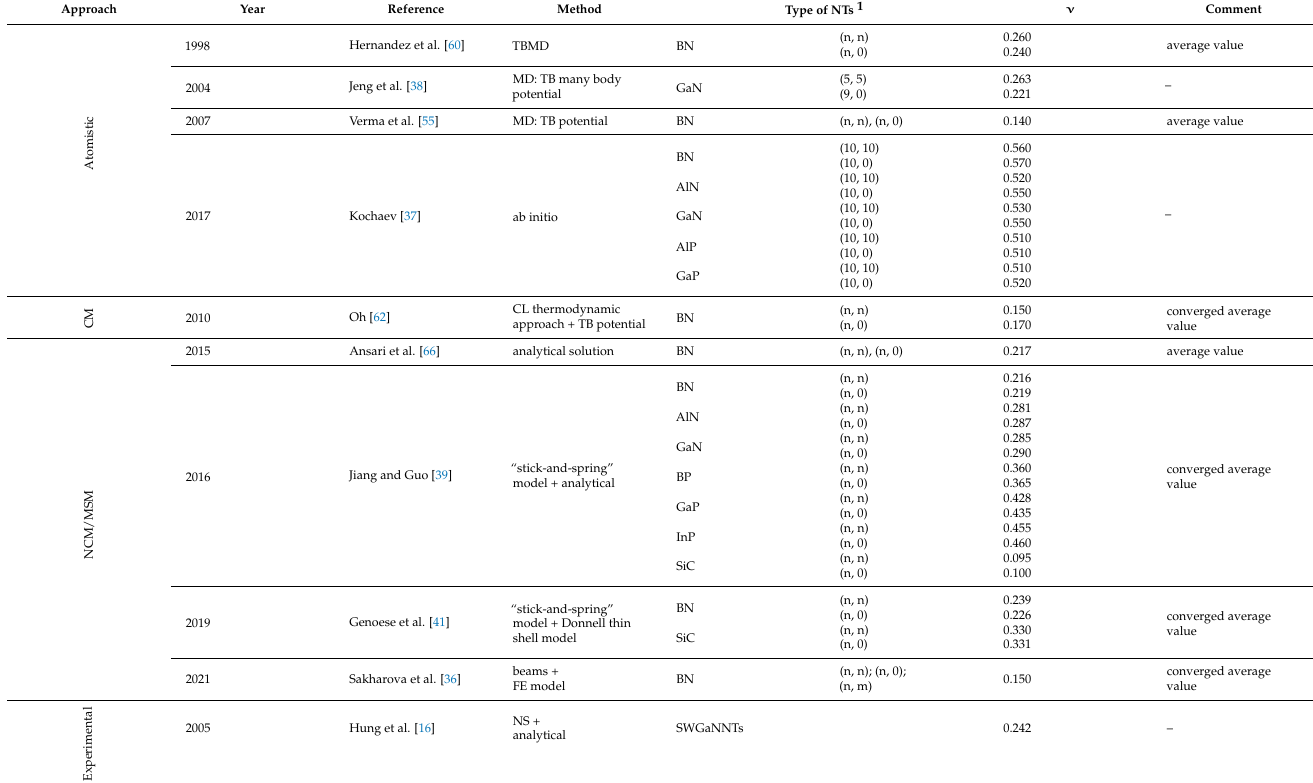
Table 3. Poisson’s ratio results for non-carbon nanotubes reported in the